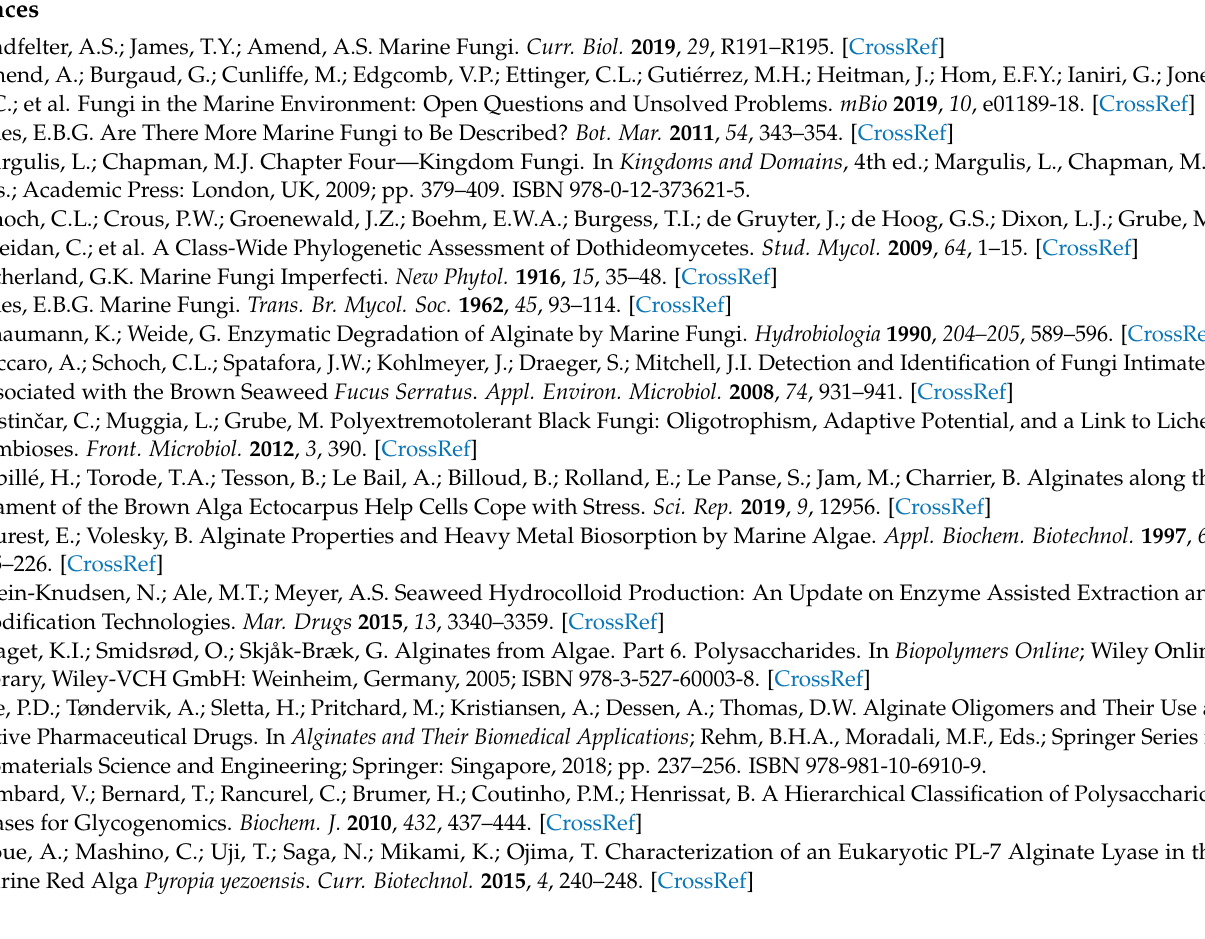
sequences, Figure S3: Dot plots of initial velocities of the recombinant enzymes, Figure S4-I-III: Bar- charts of the averaged intensities from the LC-ESI-MS analysis, Figure S5: Elution profile of observed structures from PsAlg7A acting on polyM after 120 min., Figure S6: Extracted ion chromatogram